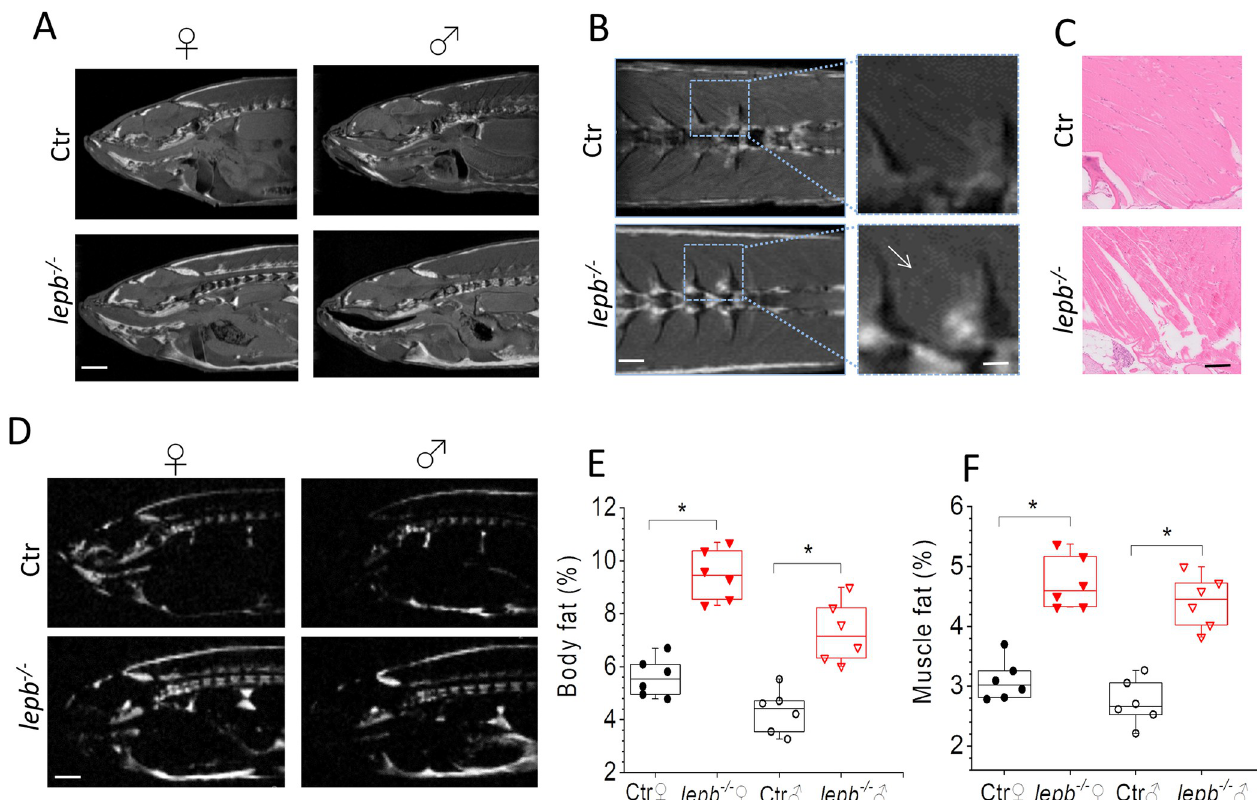
Fig 1. Magnetic resonance anatomical imaging and selective fat imaging in control (Ctr) and lepb -deficient ( lepb -/- ) adult zebrafish. (A) Representative sagittal MR images of female ( ♀ ) and male ( ♂ ) Ctr and lepb -/- zebrafish measured by RARE pulse sequence (TE = 15 ms with effective TE of 33.6 ms; TR = 2000 ms; ns = 8; Scan time 17 min). Scale bar: 1 mm. (B) Representative coronal MR images showing muscle area of female Ctr and lepb -/- zebrafish measured by RARE pulse sequence. Scale bar: 500 μ m. A zoomed view (right column) showing fat infiltration in muscles of lepb -/- zebrafish. Scale bar: 250 μ m; (C) Histological sections from the same muscle region as in (B) stained with HE staining. Scale bar: 250 μ m. (D) Images of fat distribution in the sagittal plane, acquired with Chemical Shift Selective (CHESS) pulse sequence in female Ctr and lepb -/- zebrafish. Scale bar: 1 mm; (E) Quantification of body fat in control and lepb -/- female and male adult zebrafish measured from CHESS MR images (n = 6 per group) ( *** p < 0.001); (F) Quantification of fat in muscle region from control and lepb -/- female and male adult zebrafish measured from CHESS MR images (n = 6 per group) ( *** p < 0.001).